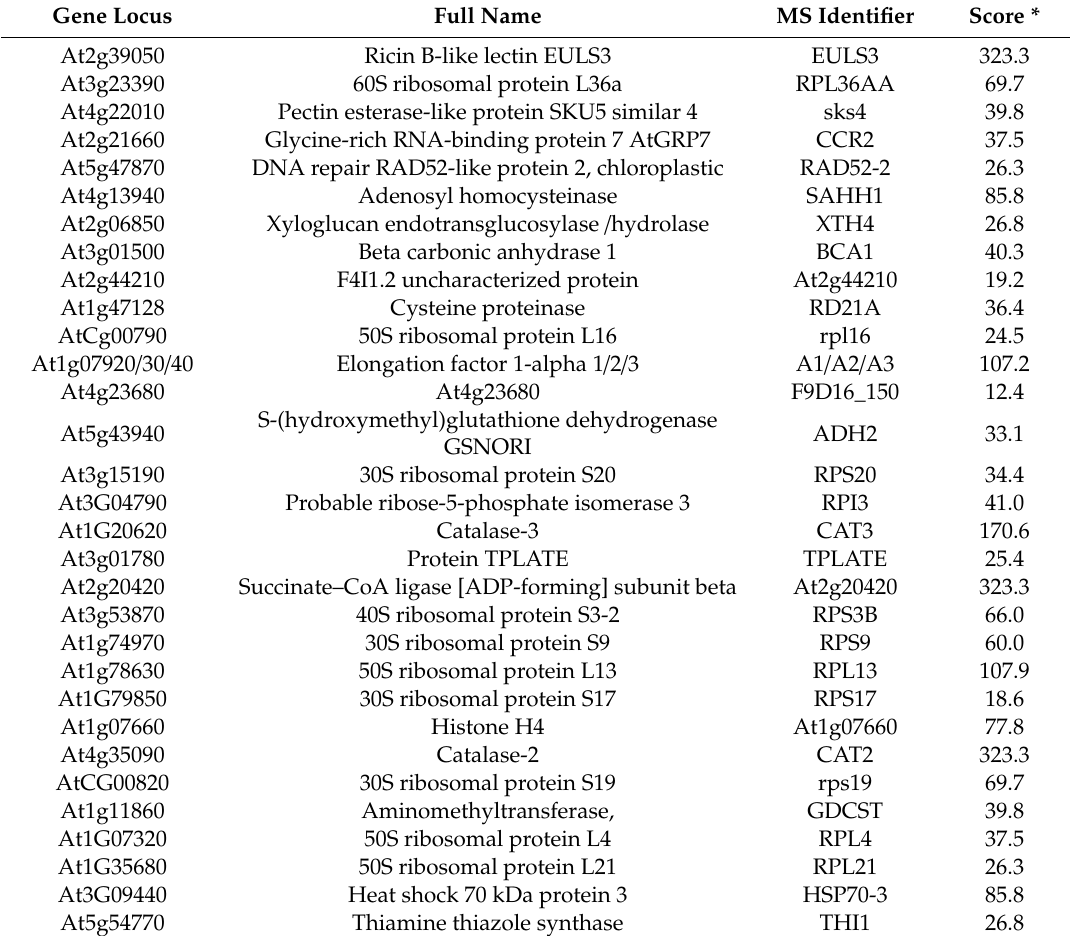
* The protein group score is the product of individual posterior error probabilities of the peptides of a protein group, and includes a factor to take into account the number of peptides per protein group. The protein group score is similar to the posterior error probabilities, in that it provides a measure of the certainty of protein